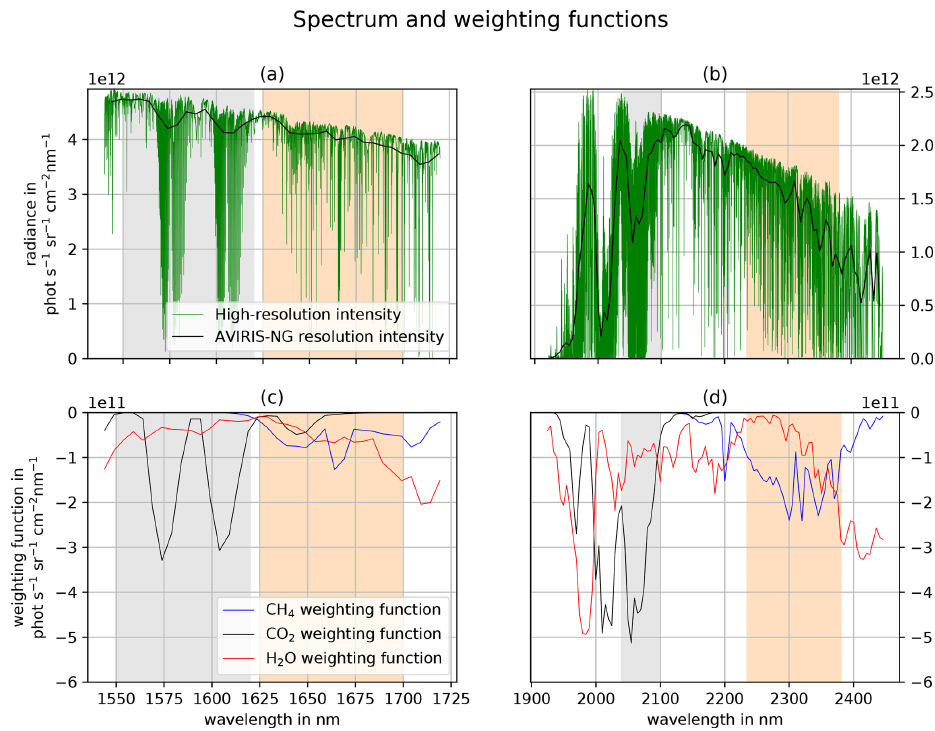
Figure 2. The high-resolution simulated spectra (in panels a and b green) are convolved with the slit function of AVIRIS-NG and sampled to the AVIRIS-NG wavelength grid (solid black line in panels a and b ). Panels (c) and (d) show the weighting functions, i.e., the change in intensity due to a change in atmospheric concentration for CH 4 (blue), CO 2 (black), and H 2 O (red). The shaded areas denote the fitting windows for CO 2 (gray) and CH 4 (light orange).